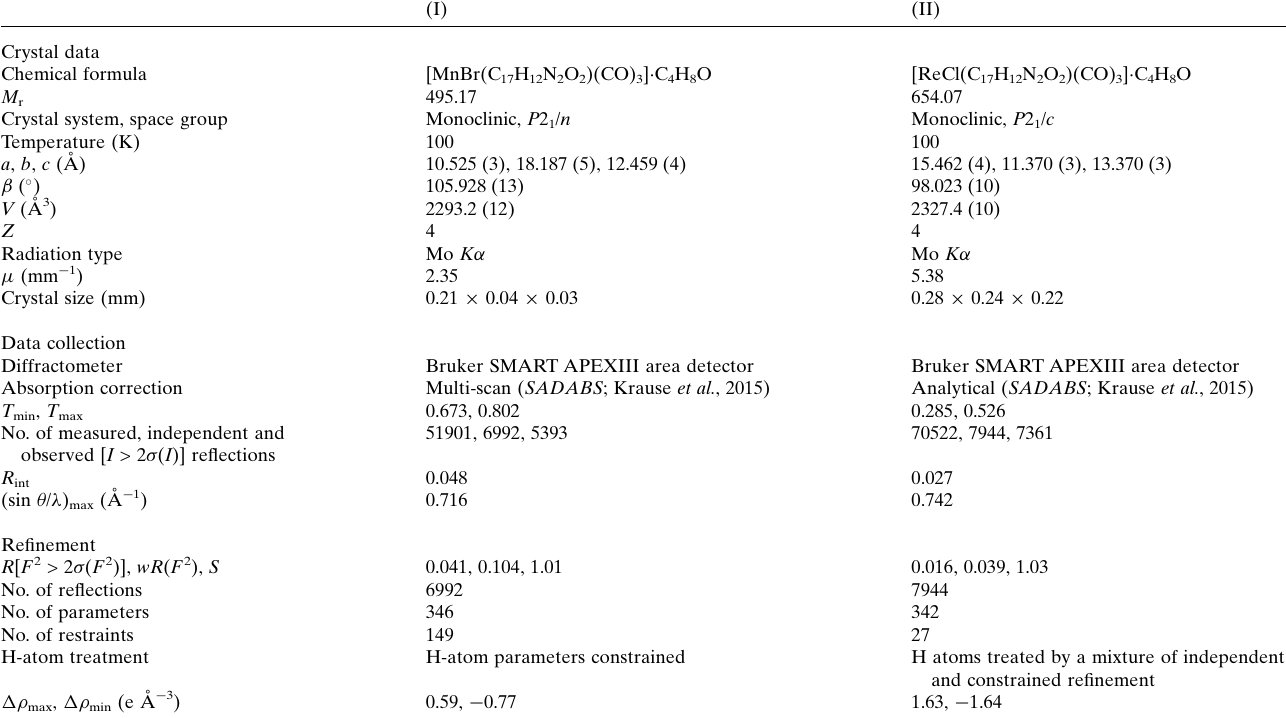
Table 3 Experimental details.